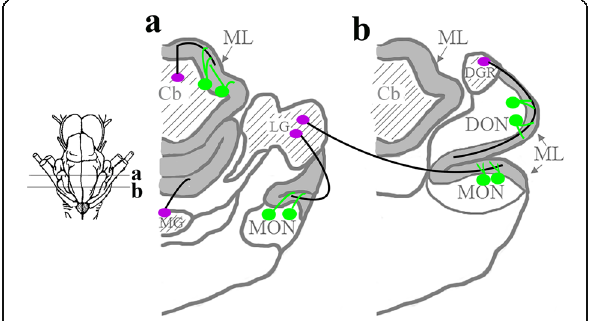
Fig. 1 Anatomical schematic of Leucoraja erinacea, showing the projections of parallel fiber axons and their synapses with the spiny apical dendrites of principal cells in the molecular layers. Principal cells are green, granule cell somata are purple, parallel fiber axons are black, molecular layers are dark grey, and granule cell masses are marked by light grey. Abbreviations: Cb , cerebellum; DGR , dorsal granular ridge; DON , dorsal nucleus; LG , lateral granule cell mass; MG , medial granule cell mass; MON , medial